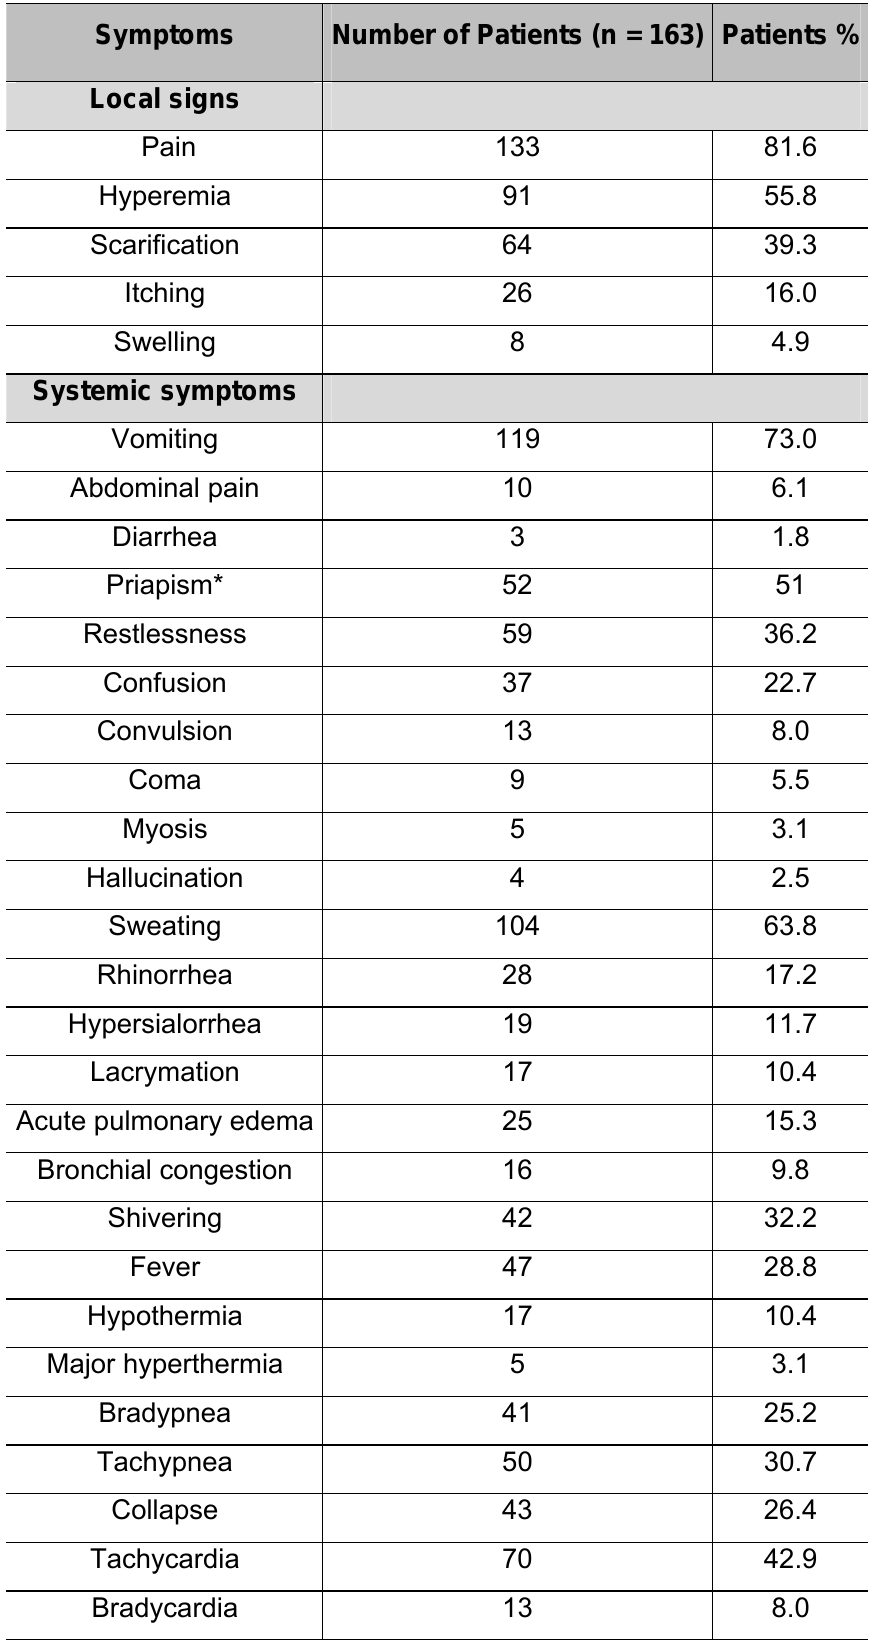
Table 3. Clinical symptoms developed by victims of scorpion stings